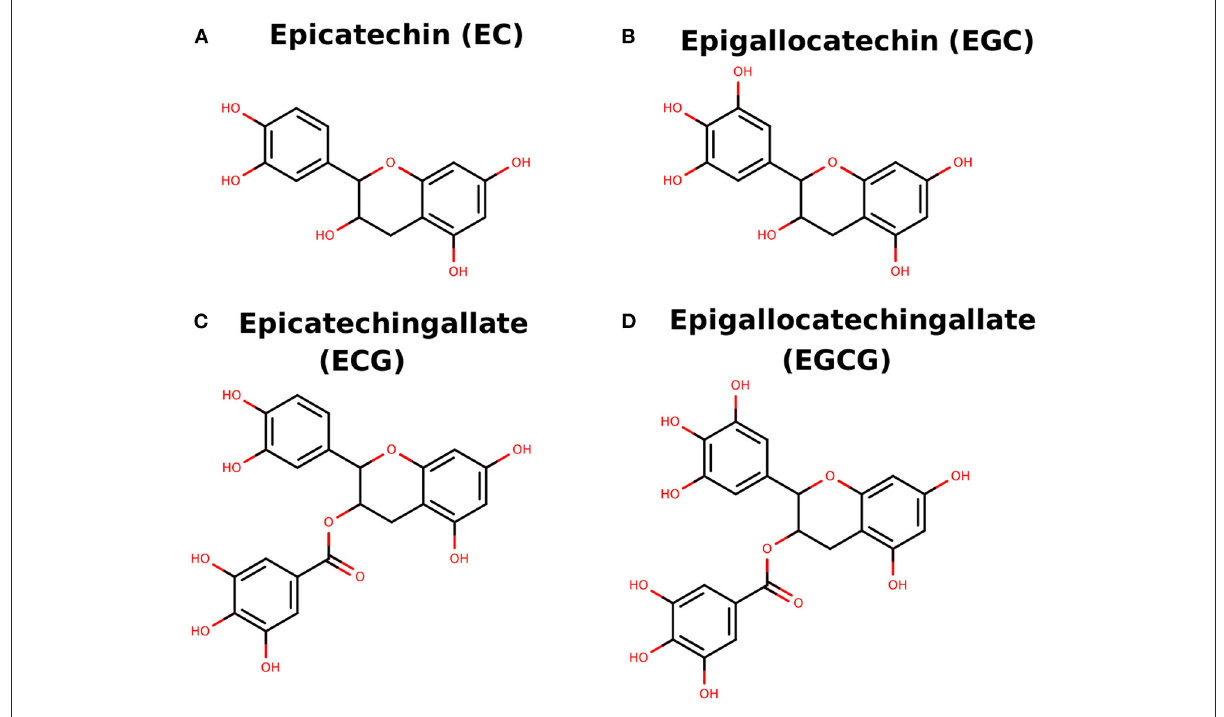
FIGURE1 (A–D) Two-dimensional sketch of EC, EGC, ECG, and